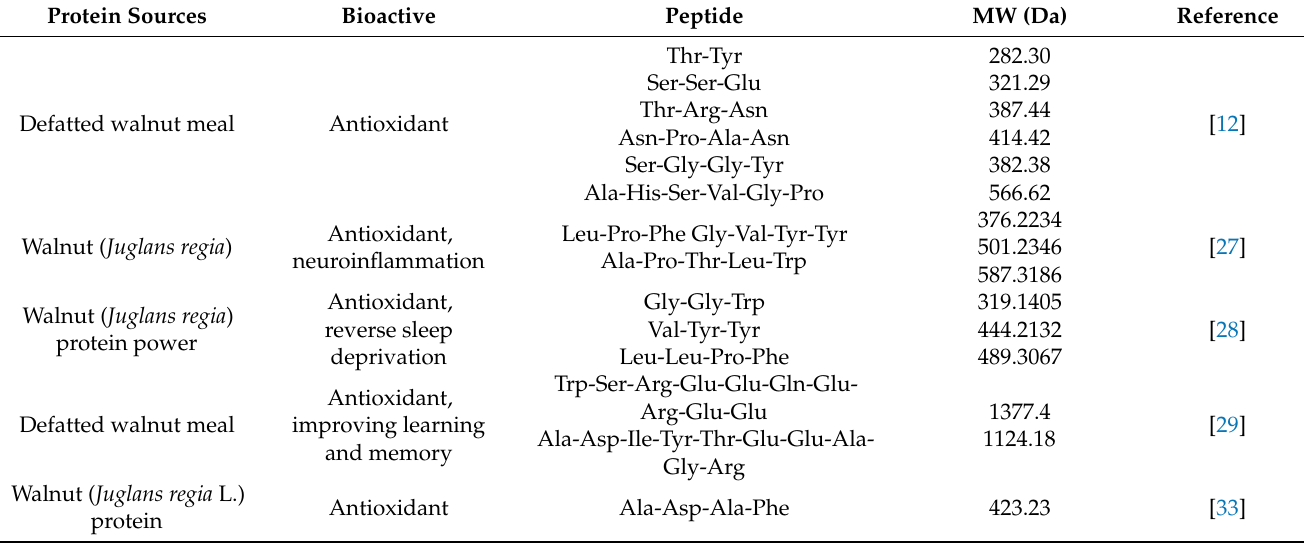
Table 6. The SAR of nut-derived